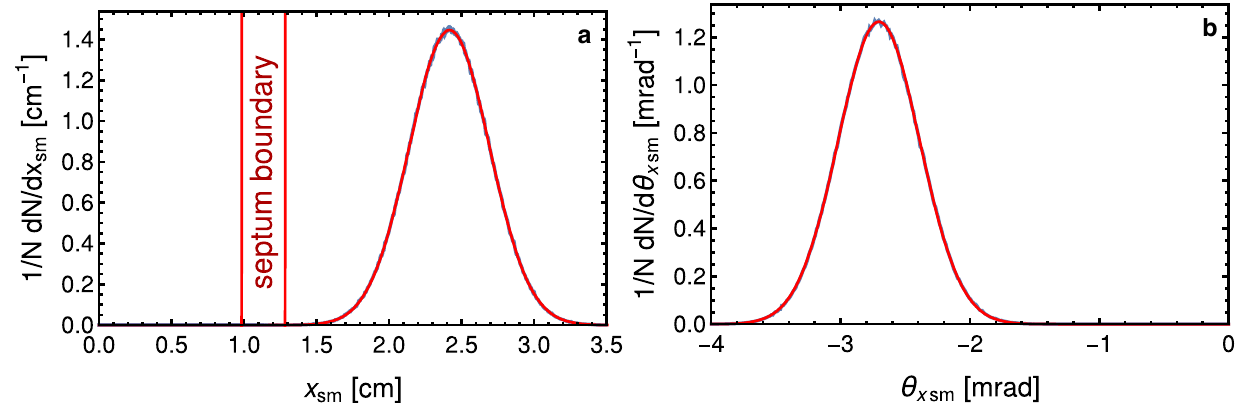
Fig. 6 Transverse a spatial coordinate and b angular distributions of the beam at the position of the septum magnet with the condition of a constant angular kick of the deflection device of 1.75 mrad. Vertical lines in a indicate the septum magnet boundary. The red curves indicate the results of Gaussian